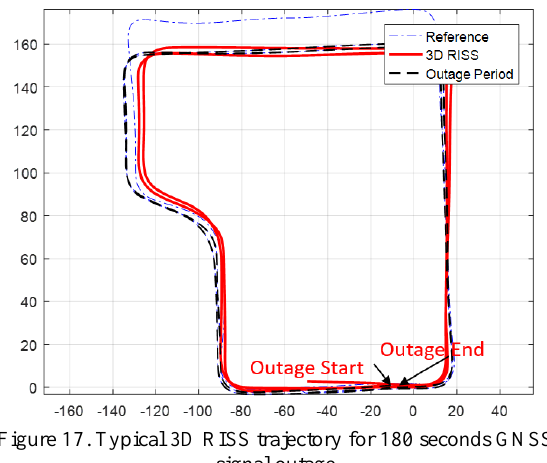
Figure 17. Typical 3D RISS trajectory for 180 seconds GNSS signal outage